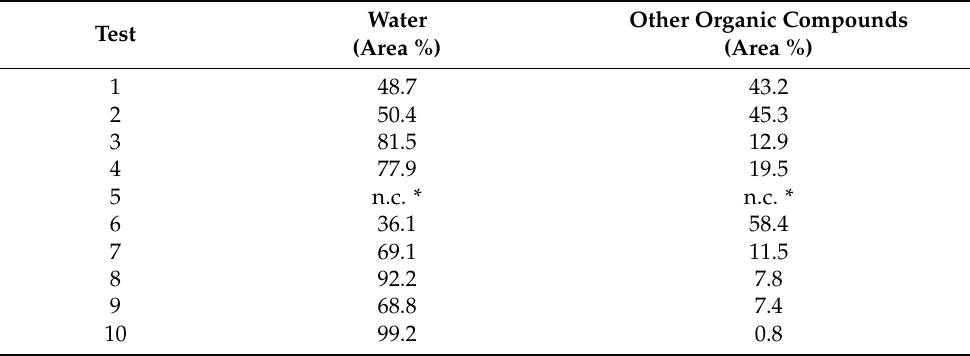
Table 5. Main composition of the liquid collected in the combustion tests of